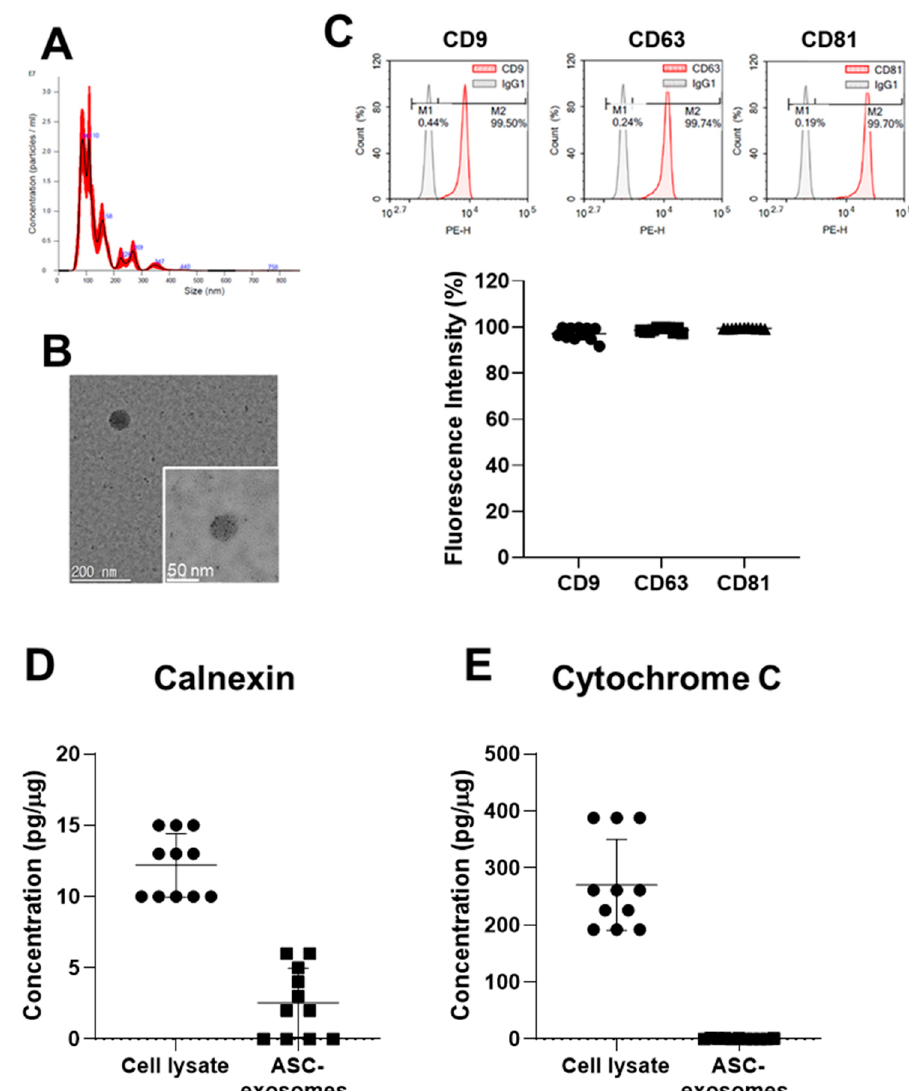
Figure 3. Characteristics of ASC-exosomes produced by the tangential flow filtration (TFF)-based ExoSCRT ™ technology. ( A ) Representative nanoparticle tracking analysis (NTA) histogram of particle concentration and size distribution of ASC-exosomes. ( B ) Representative TEM images of ASC-exosomes. ( C ) Representative histograms and cumulative results of FCM analysis of ASC-exosomes ( n = 11). Amounts of calnexin ( D ) and cytochrome C ( E ) in ASC-exosomes measured by ELISA ( n = 11).